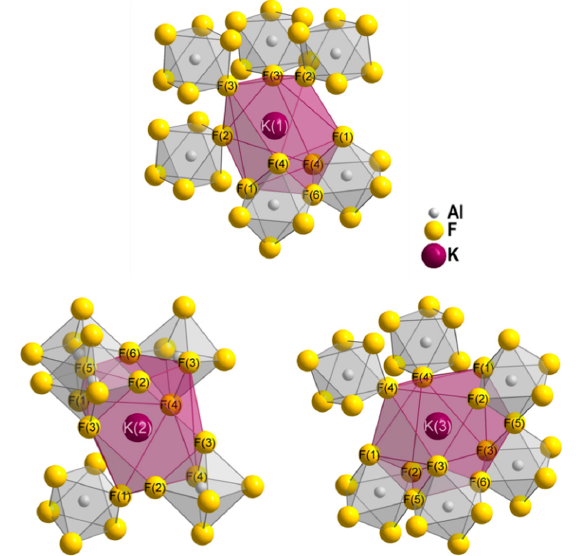
Figure 4. Potassium site coordination by AlF 6 -octahedra in K 2 AlF 5 -2. Each potassium site connects three fluoridoaluminate chains.